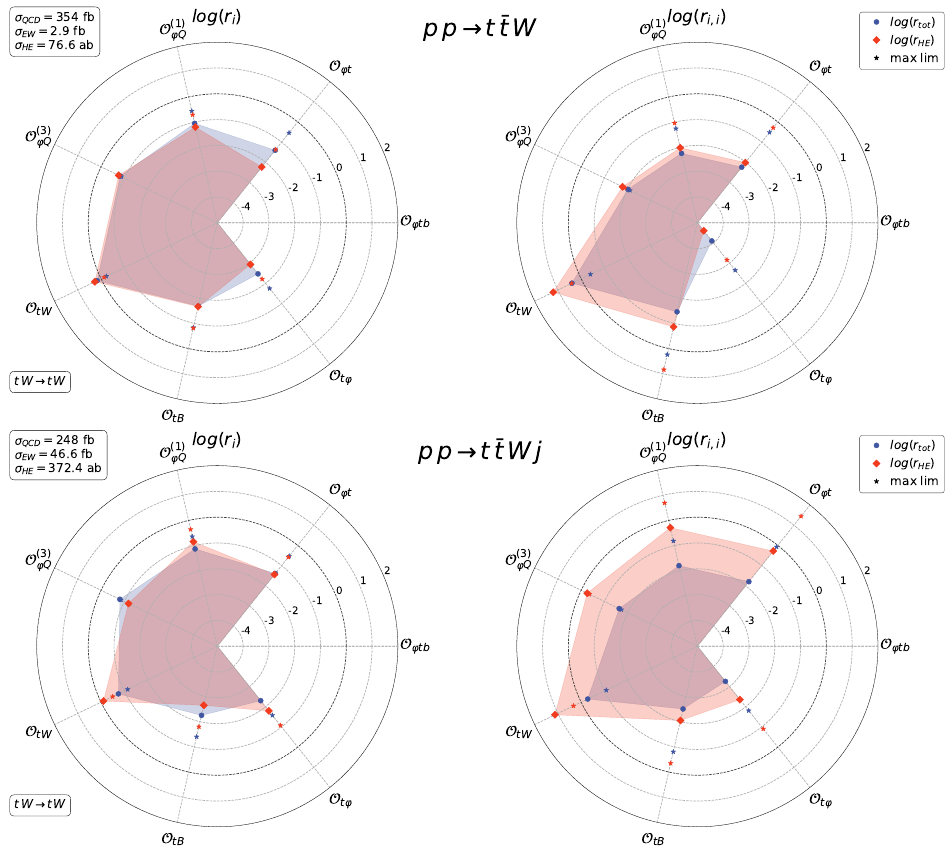
Figure 19. Radar plot for the p p 13 TeV LHC, see (cid:12)gure 7 and section 4.1.2 of the main text for a detailed description.